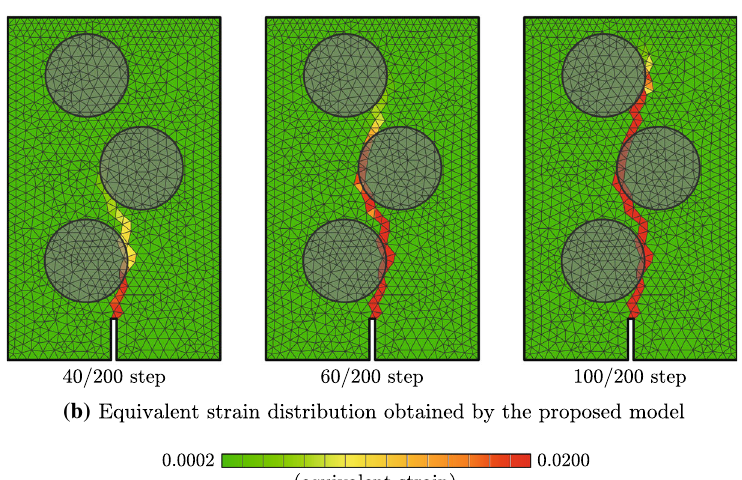
Fig. 10 Comparison of damage propagation: left figures show the reference solutions; right figures present the results obtained by the proposed model